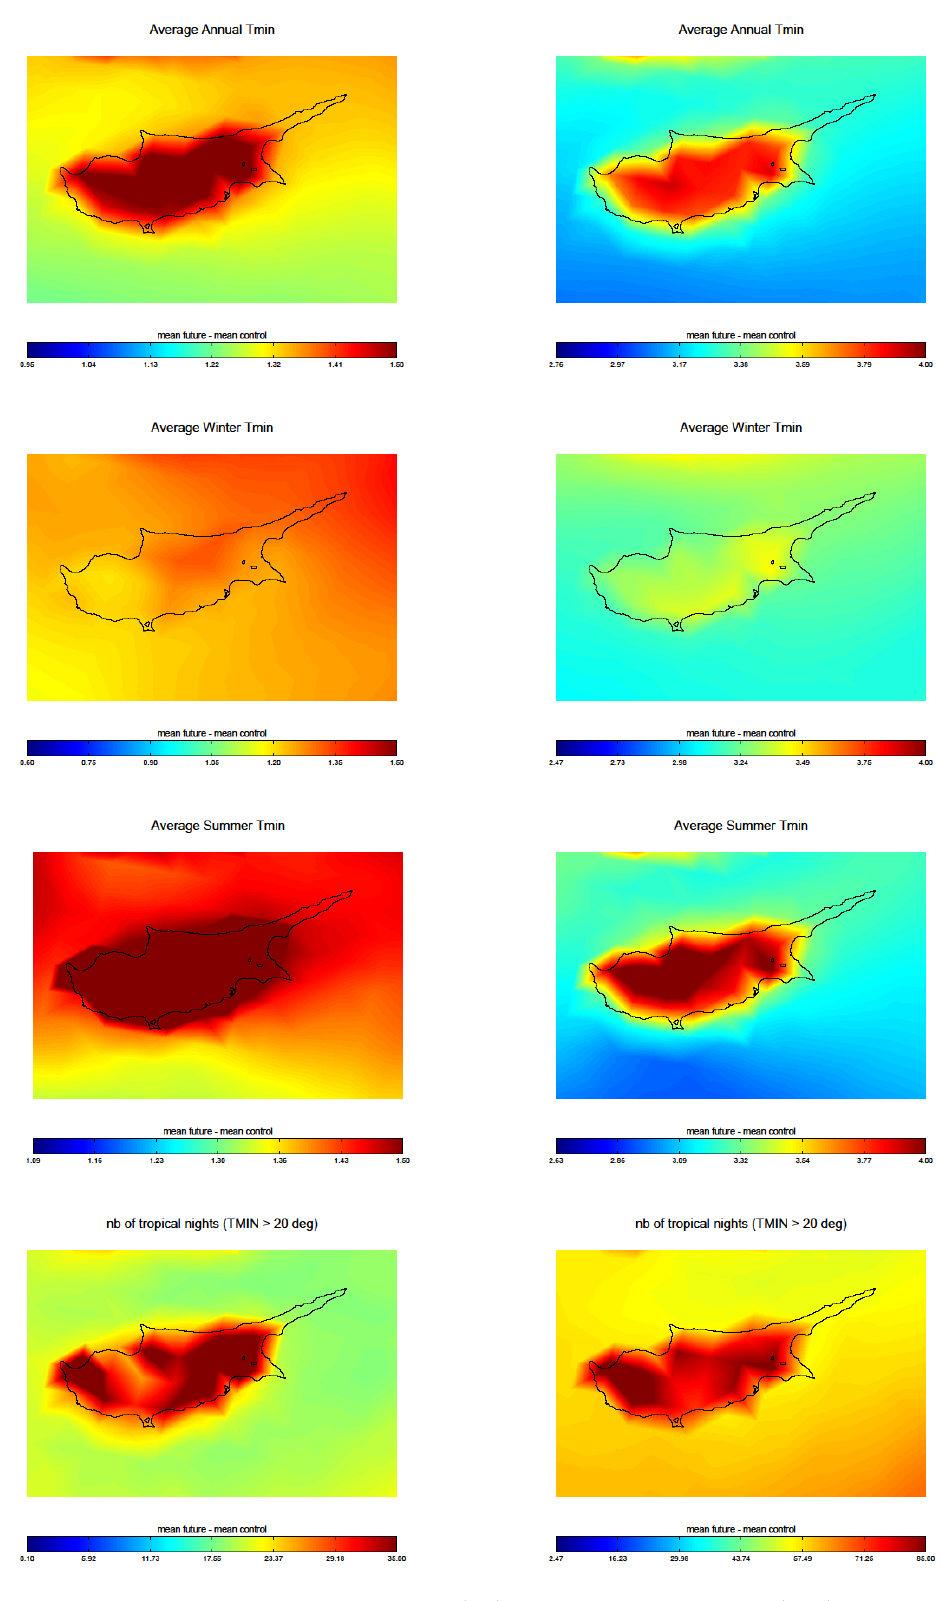
Fig. 3. Mean differences between the 2021–2050 future simulation (left), the 2071–2100 future period (right) and the control run period for the average annual T min , average winter T min , average summer T min , number of tropical nights with T min > 20 ◦